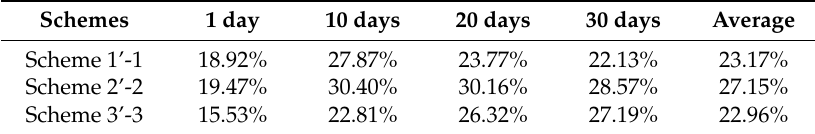
Table 5. Reduction rates of Sip after being